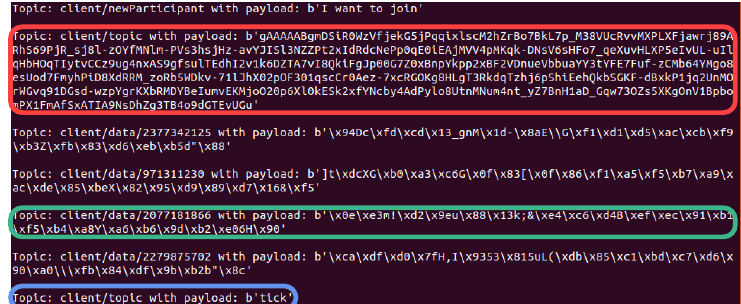
Figure 9. Broker’s